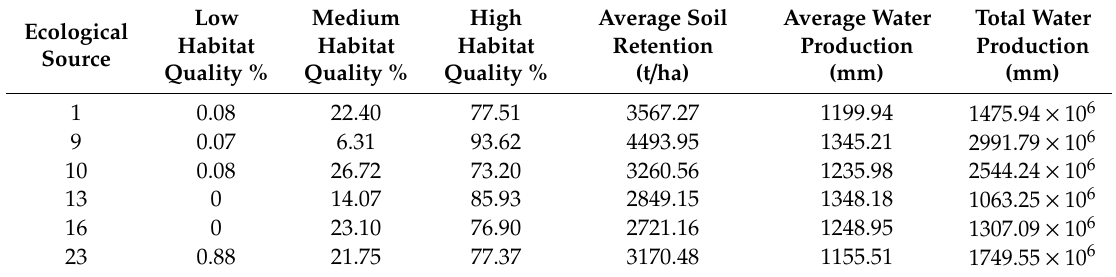
Table 4. Ecosystem service of each ecological source